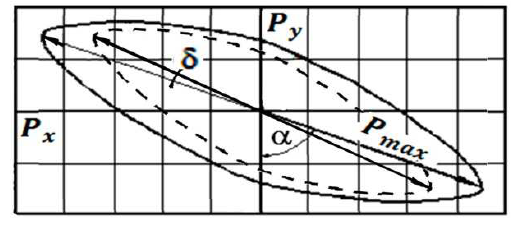
Figure 4. Shear force hodograph diagram